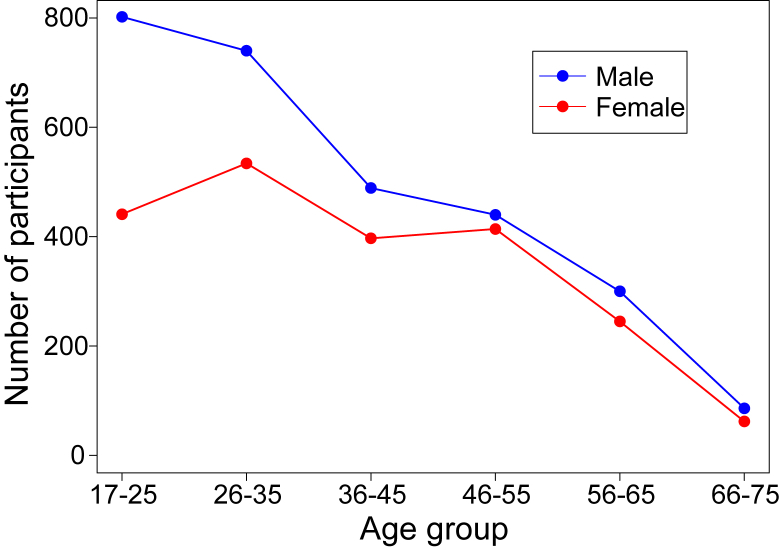
Number of participants by age group and gender.